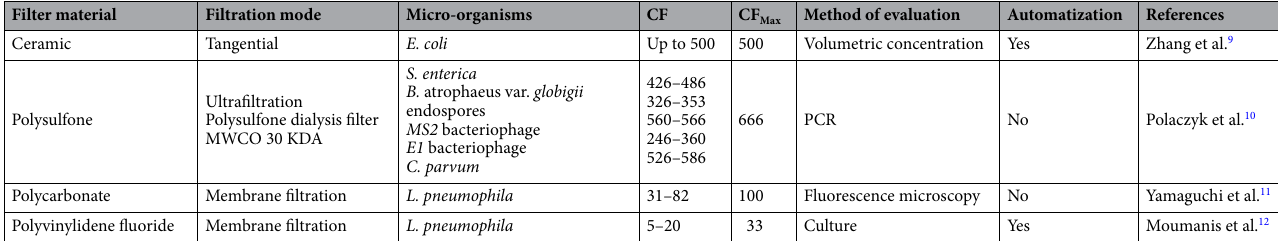
Table 1. Examples of filtration methods and concentration factors in microbial